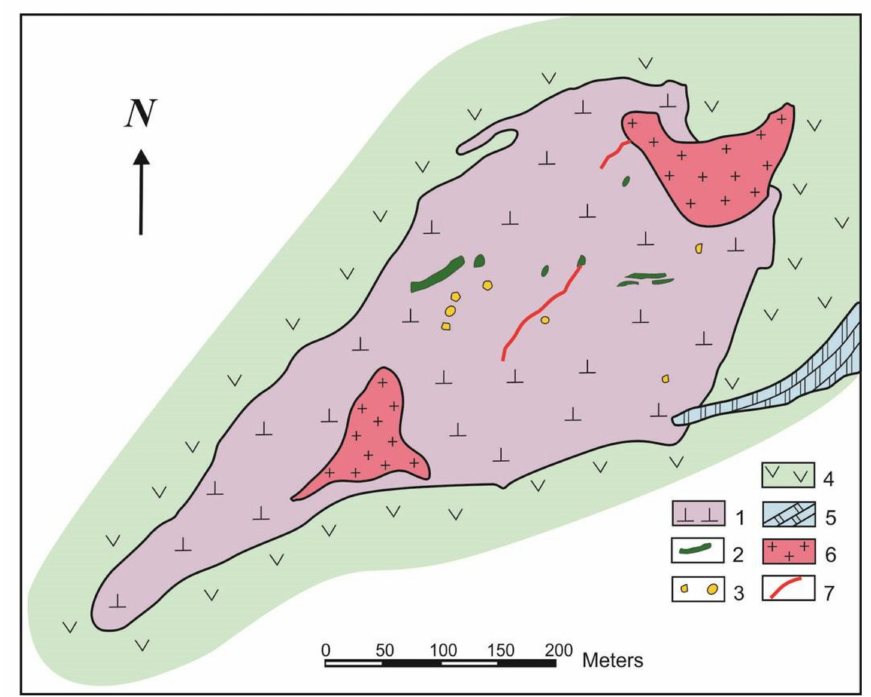
Figure 6. Geological map of Tog peridotite. 1 = dunite and harzburgite; 2 = amphibolite and garnet amphibolite in peridotites; 3 = magnetite–amphibole–chlorite rocks in peridotites; 4 = amphibolite; 5 = calcite marble; 6 = granite and pegmatite; 7 = pegmatite veins.